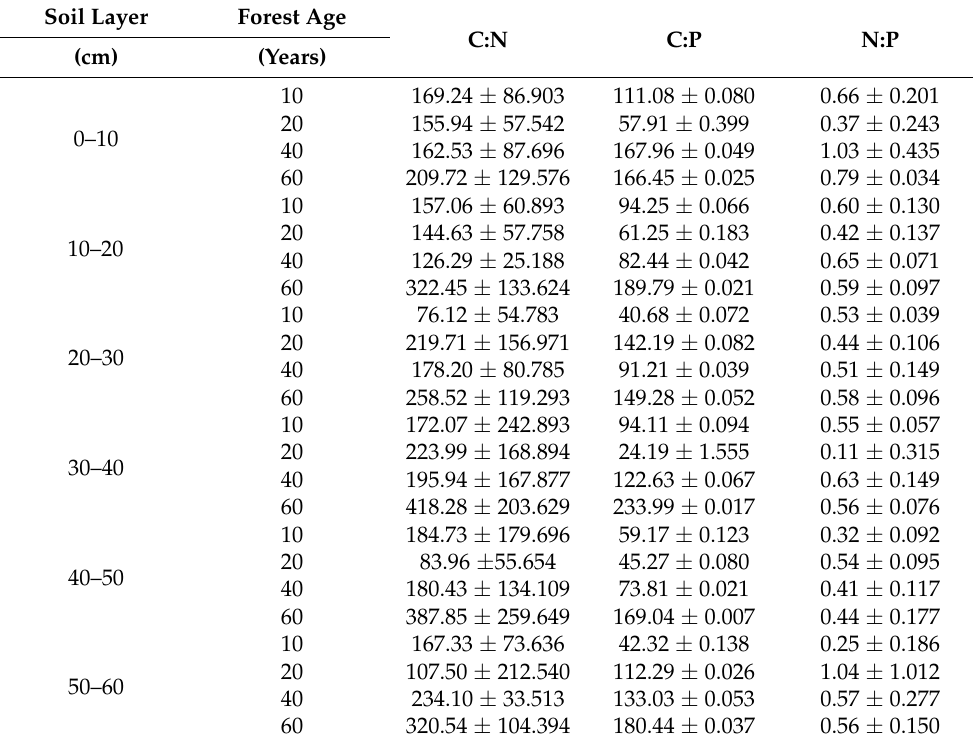
Table 3. C:N ratio, C:P ratio, and N:P ratio in different-aged forests. The mean ± standard deviation is shown in the table; C:N, C:P, and N:P represent the ratios of soil total organic carbon to total nitrogen, total organic carbon to total phosphorus, and total nitrogen to total phosphorus,